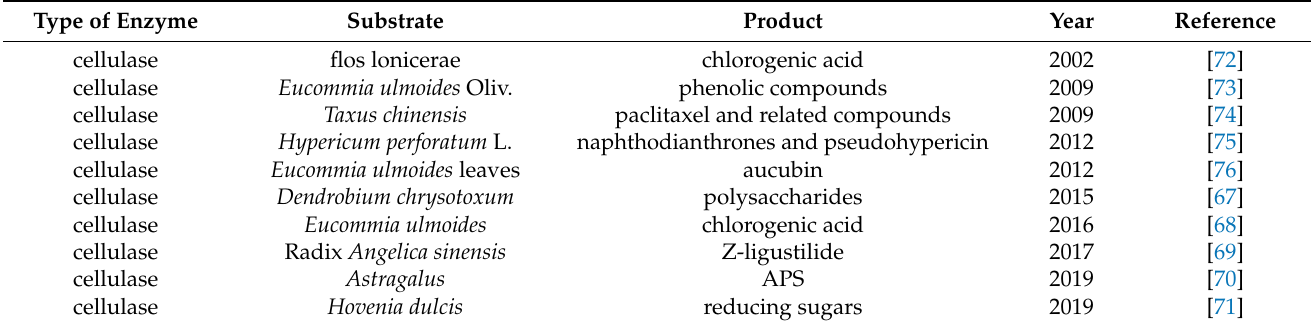
Table 5. Application of cellulase in the extraction of bioactive